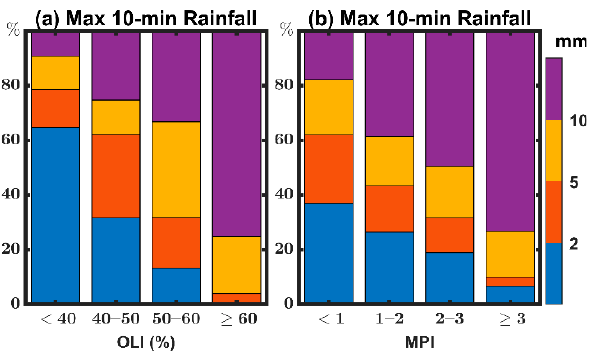
Figure 14. Distribution of the maximum 10 ‐ min rainfall in the next hour produced by the MCS samples during EP1 and EP2, as a function of ( a ) OLI and ( b ) MPI. The maximum 10 ‐ min rainfall in the next hour is calculated as the average of the top five 10 ‐ min rainfalls belonging to an MCS sample.